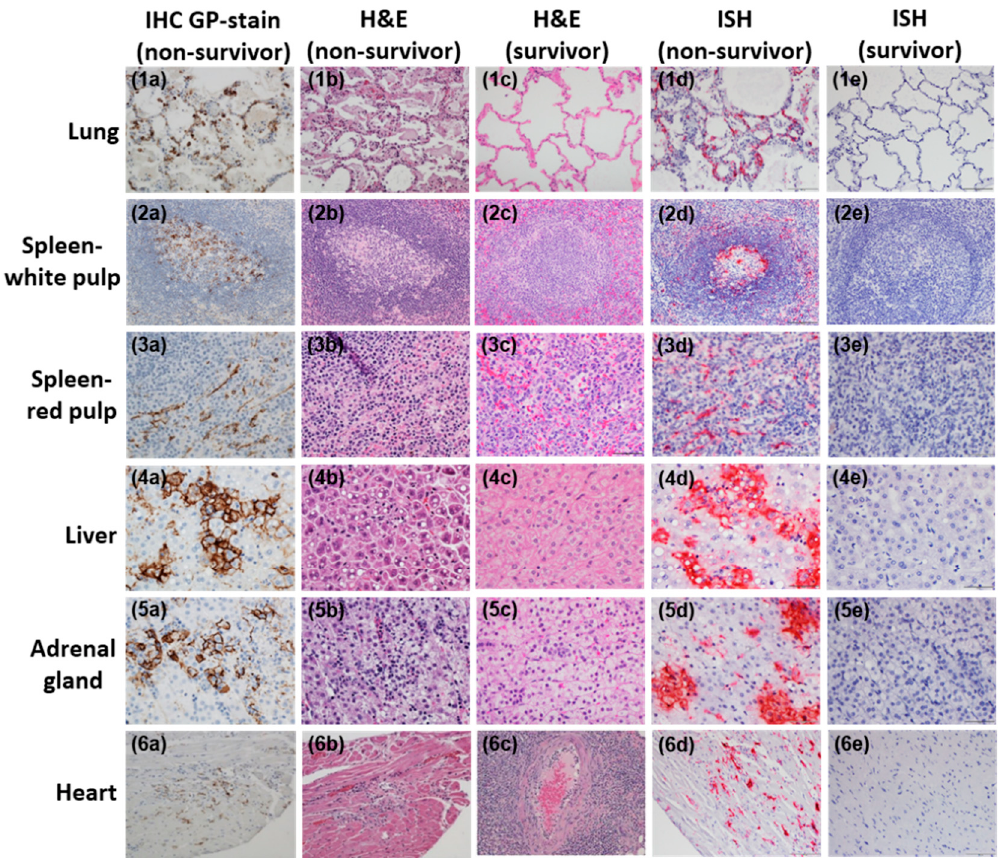
Figure 8. Pathological assessment of tissues of aerosol infected non-human primates. Lung (1a-1e, 20X), spleen-white pulp (2a-2e, 40X), spleen-red pulp (3a-3e, 40X), liver (4a-4e, 40X), adrenal gland spleen-white pulp ( 2a – 2e , 40 × ), spleen-red pulp ( 3a – 3e , 40 × ), liver ( 4a – 4e , 40 × ), adrenal gland ( 5a – 5e (5a-5e, 40X), and heart (6a-6e, 20X). Tissues were from ● survivor on DPE 41 (all tissues), ■ D10:non-survivor (lung and heart) and ▼ D10:non-survivor.2 (liver, spleen tissues, and adrenal